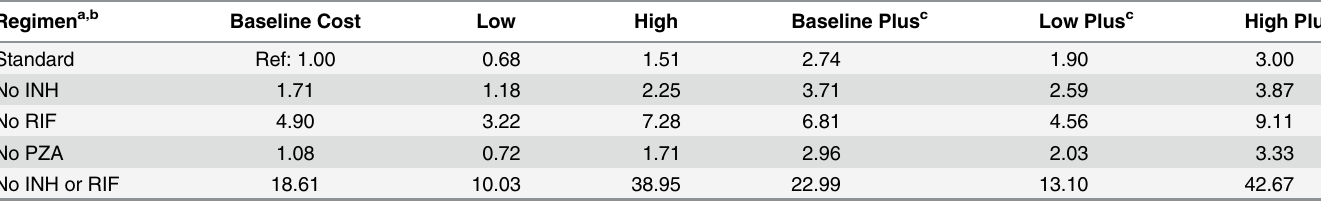
Table 4. Cost ratios of candidate regimens relative to the standard TB